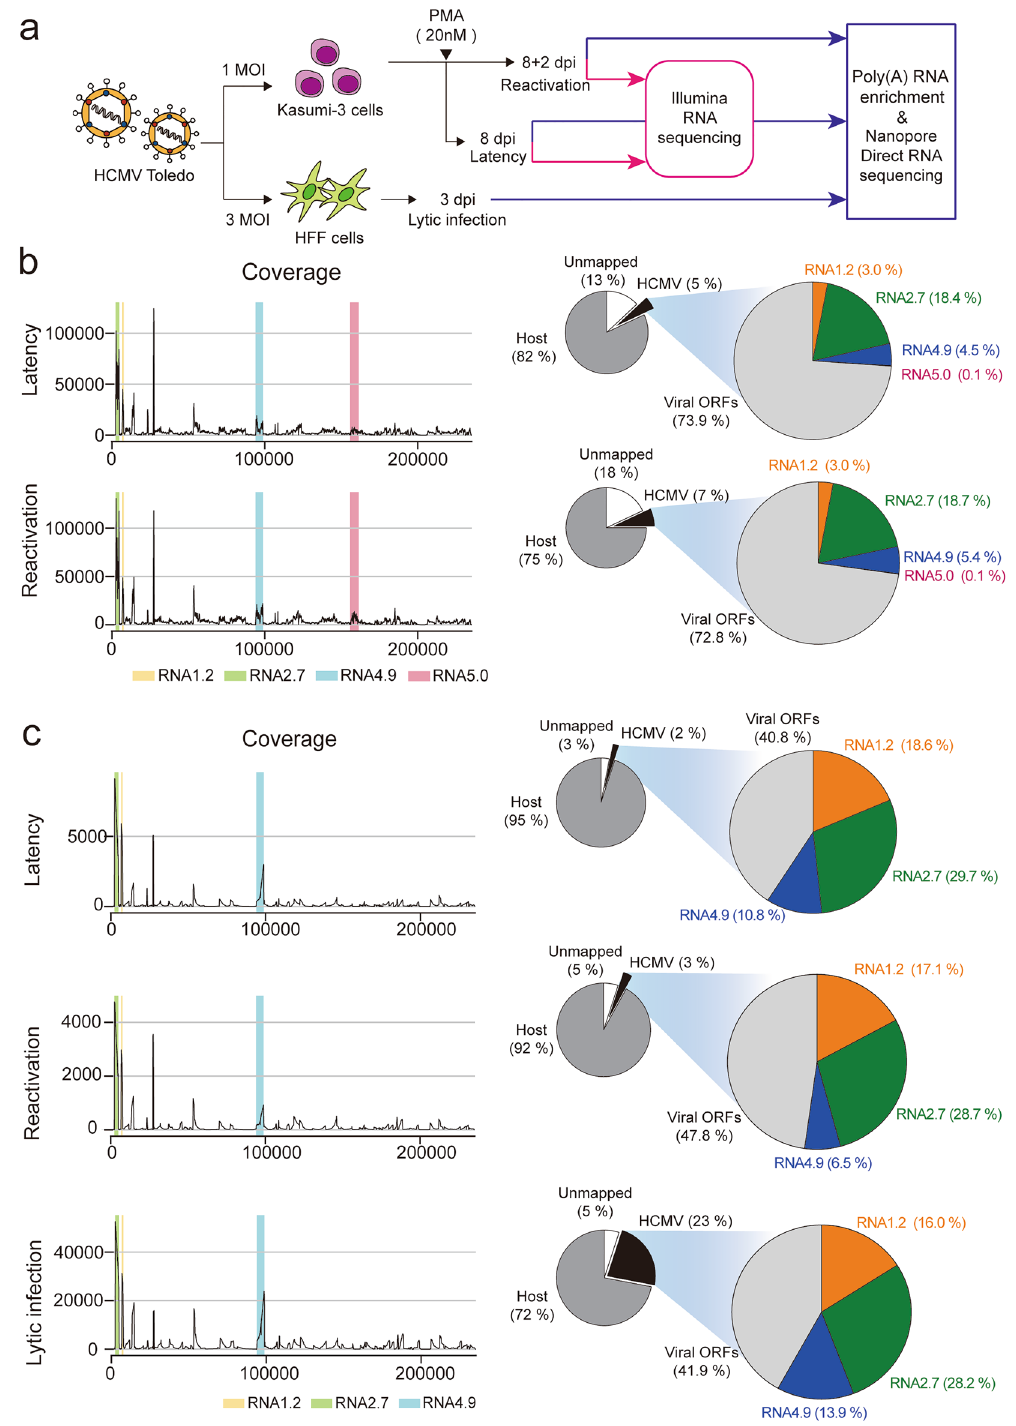
Figure 1. Profiling of HCMV lncRNAs by Illumina sequencing and nanopore DRS ( a ) Schematic of the sequencing strategies for profiling HCMV lncRNAs in various infections state. ( b ) Coverage of HCMV genome mapped reads (left) and statistics of read counts (right) from RNA-seq in latency and reactivation. ( c ) Coverage of HCMV genome mapped reads (left) and statistics of read counts (right) from nanopore DRS in latency, reactivation, and lytic infection